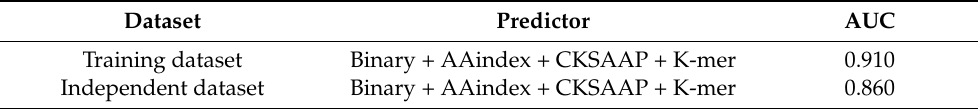
Table 5. Prediction performance of the PredNTS with feature selection.